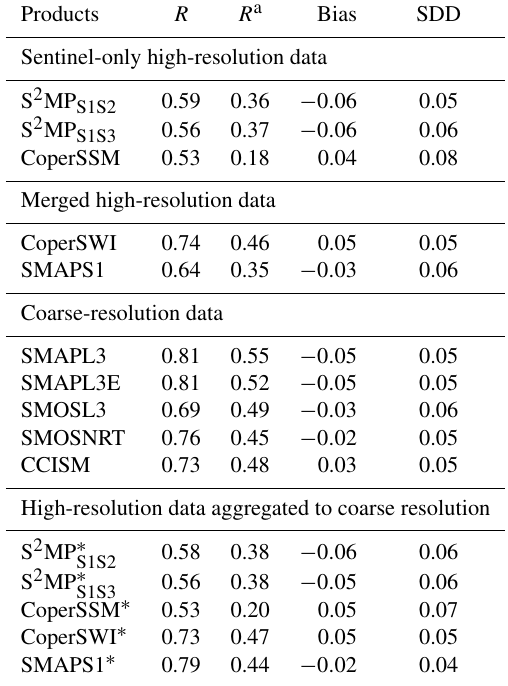
Table 4. Evaluation of the HR and CR SM time series against in situ measurements in terms of Pearson correlation ( R ; R a ), bias (remotely sensed minus ground-based SM in (m 3 m − 3 ) and stan- dard deviation of the difference (SDD in m 3 m − 3 ). The metrics were computed by taking into account the six regions of study, and only the median values are shown here. The asterisk ∗ indicates the HR datasets averaged at 25km resolution. The analysis was per- formed from January to December